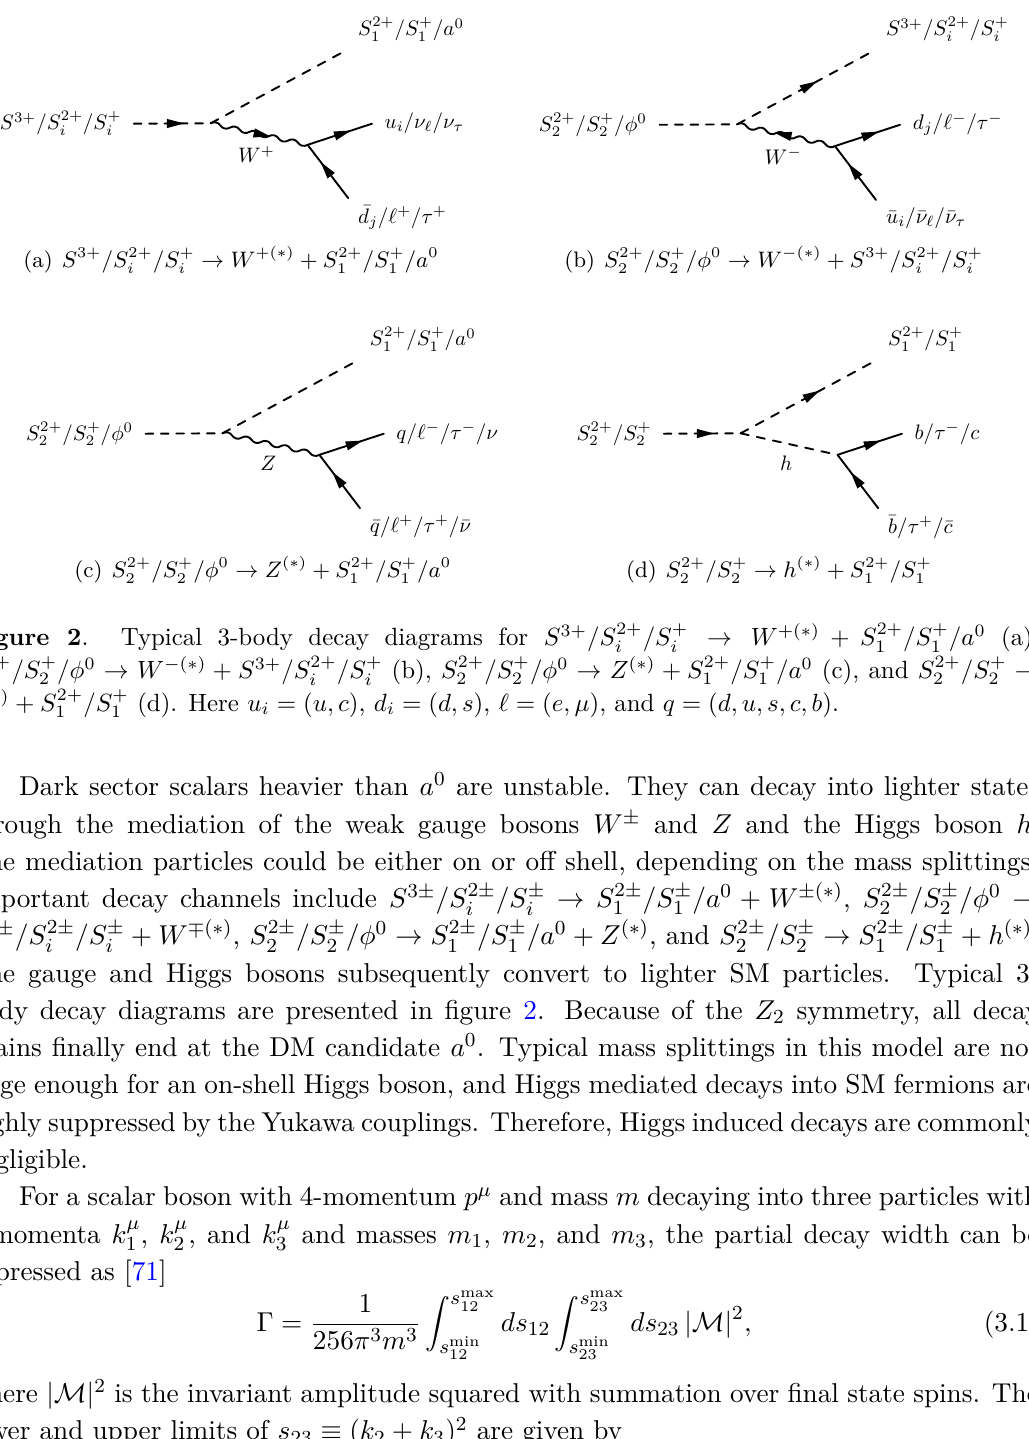
/S + /a 0 (a), 1 1 /S + → 2 2